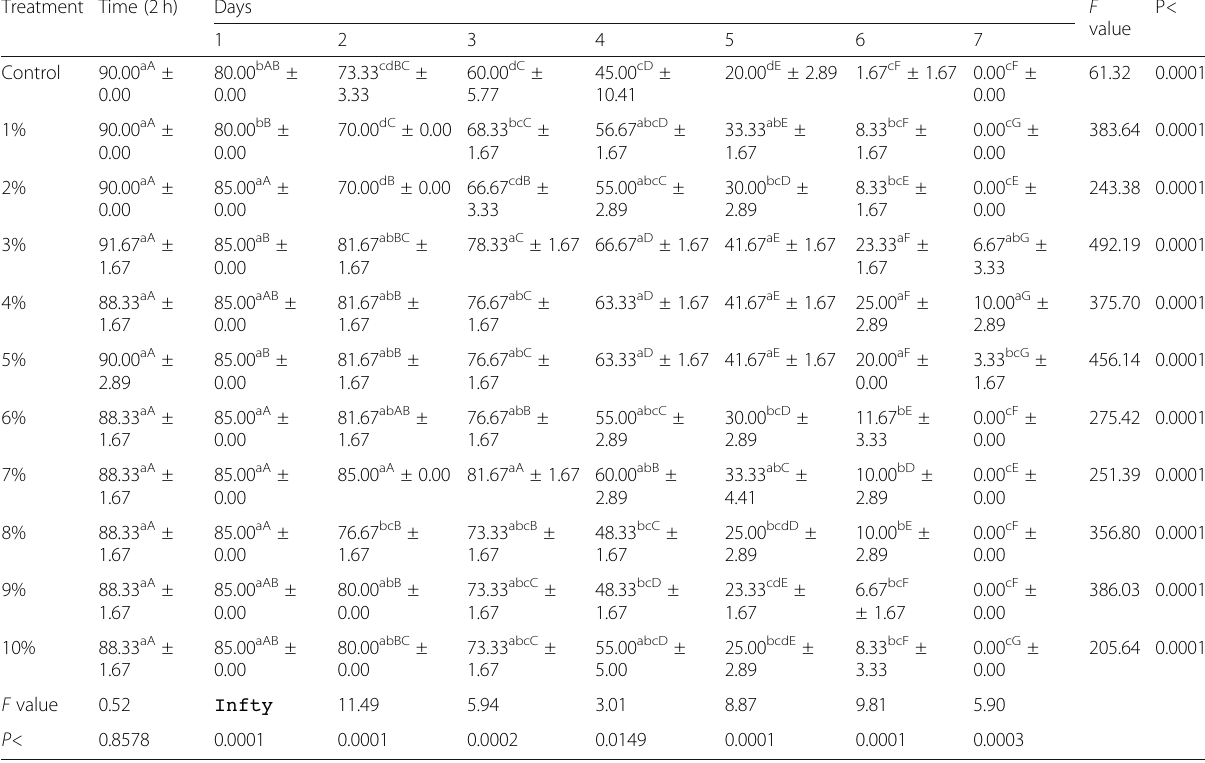
Mean ± S.E. Different small letter superscripts indicate a significant difference between means within column (for treatment) using the multiple range Duncan ’ s test at P < 0.05 Different capital letter superscripts indicate a significant difference between means within row (for time) using the multiple range Duncan ’ s test at P <